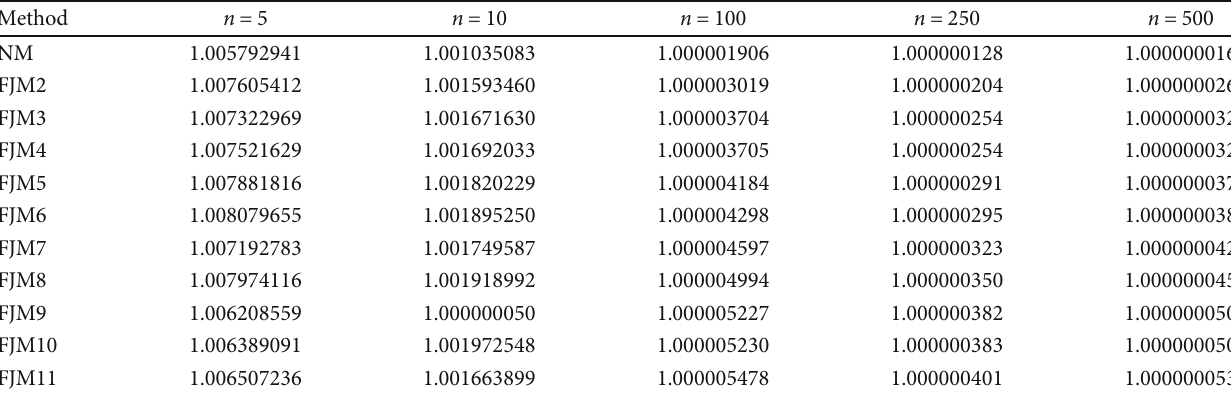
Table 33: Values of CEI for the methods in the third category to solve Test Problem 1, and n = 5,10,100,250,500 .